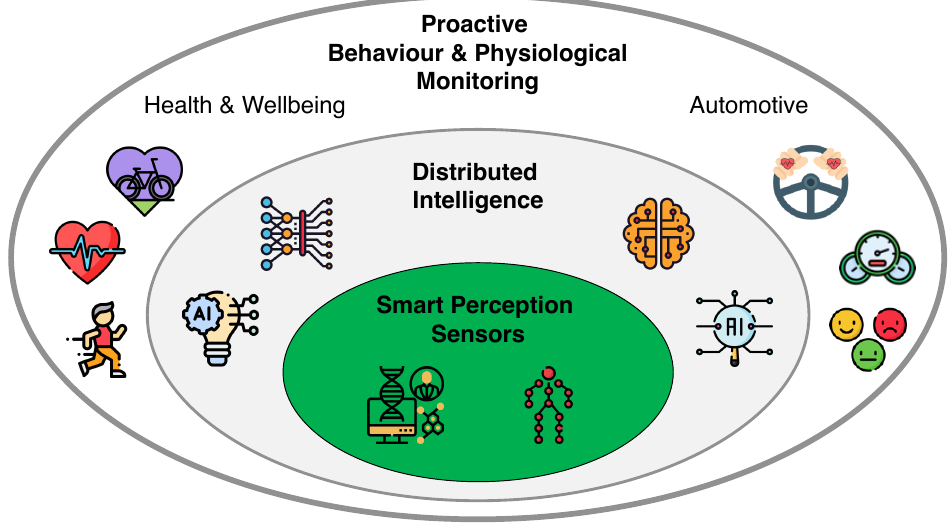
Figure 7. EU-funded NextPerception project